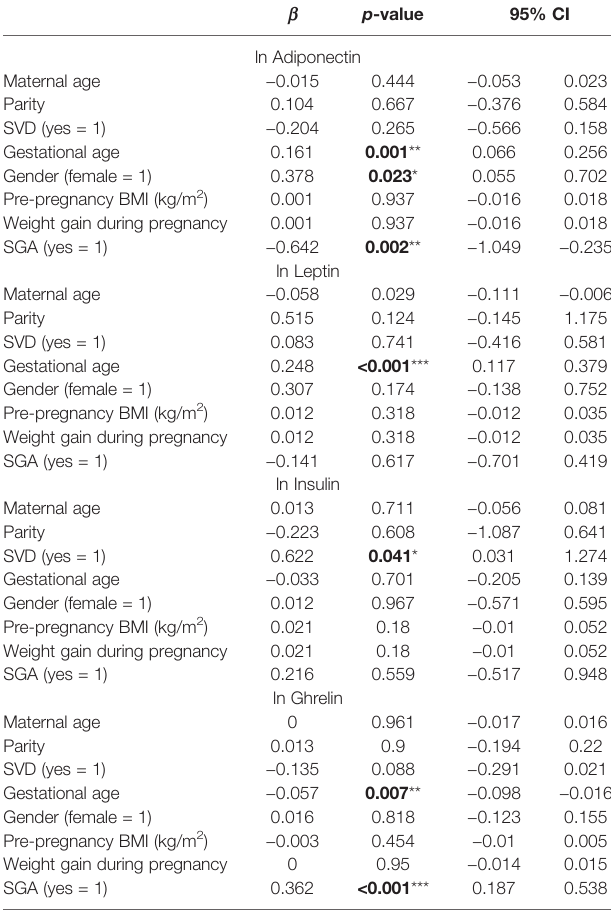
TABLE 3 | Multivariate linear regression analysis of the in fl uencing factors for the levels adiponectin, leptin, true insulin, and ghrelin in cord blood. b